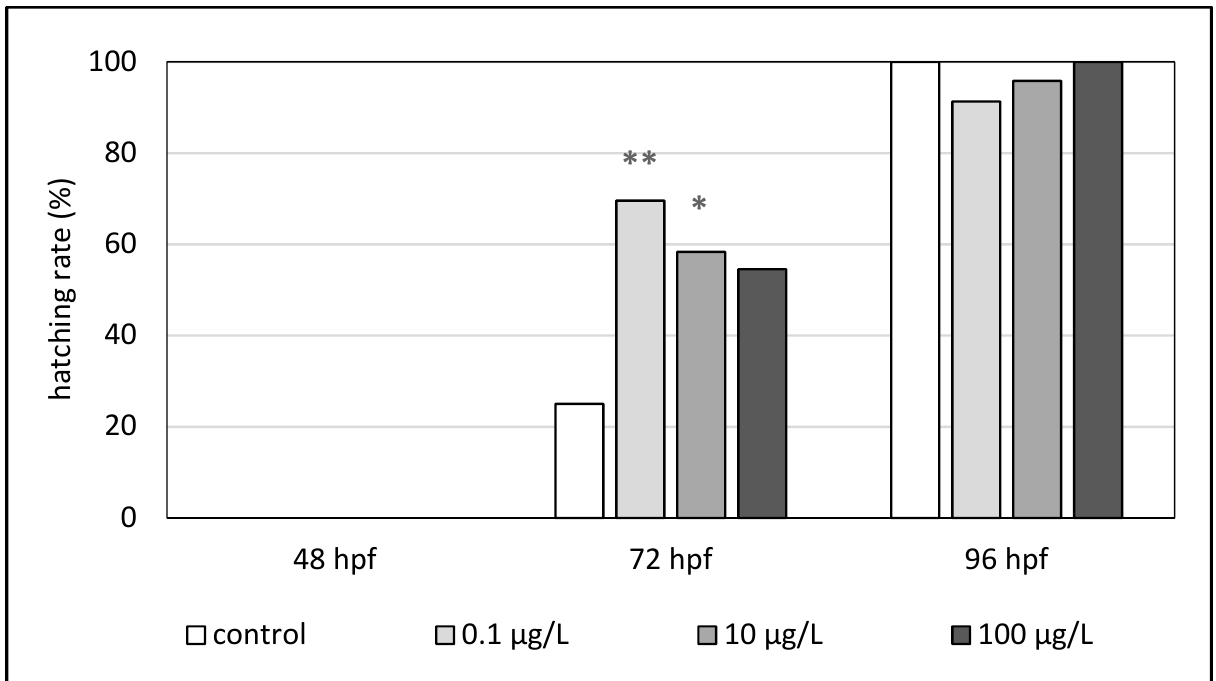
Figure 6. Hatching rate (%) of zebrafish embryos exposed to the combination of 2-phenylbenzimid- azole-5-sulfonic acid, benzophenone-3 and ethylhexyl methoxycinnamate (hpf—hours post fertili- zation). The asterisk indicates a significant difference (* p < 0.05) between the control and experi- mental groups at the same time of exposure.